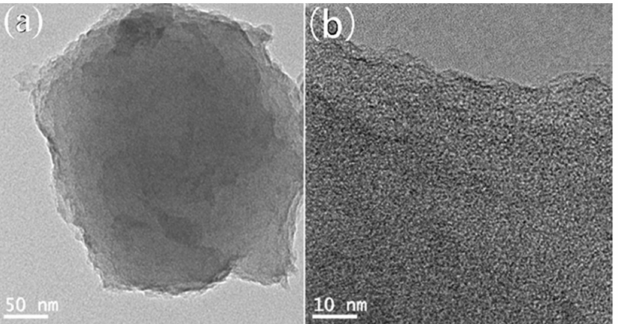
Figure 2. TEM image of 2APCNs-1: ( a ) Low magnification TEM image; ( b ) High magnification TEM image.